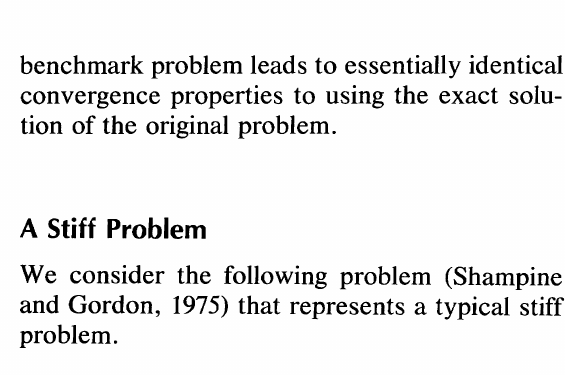
FIGURE 18 Absolute error vs. tolerance for the Euler equations (DIVPRK).